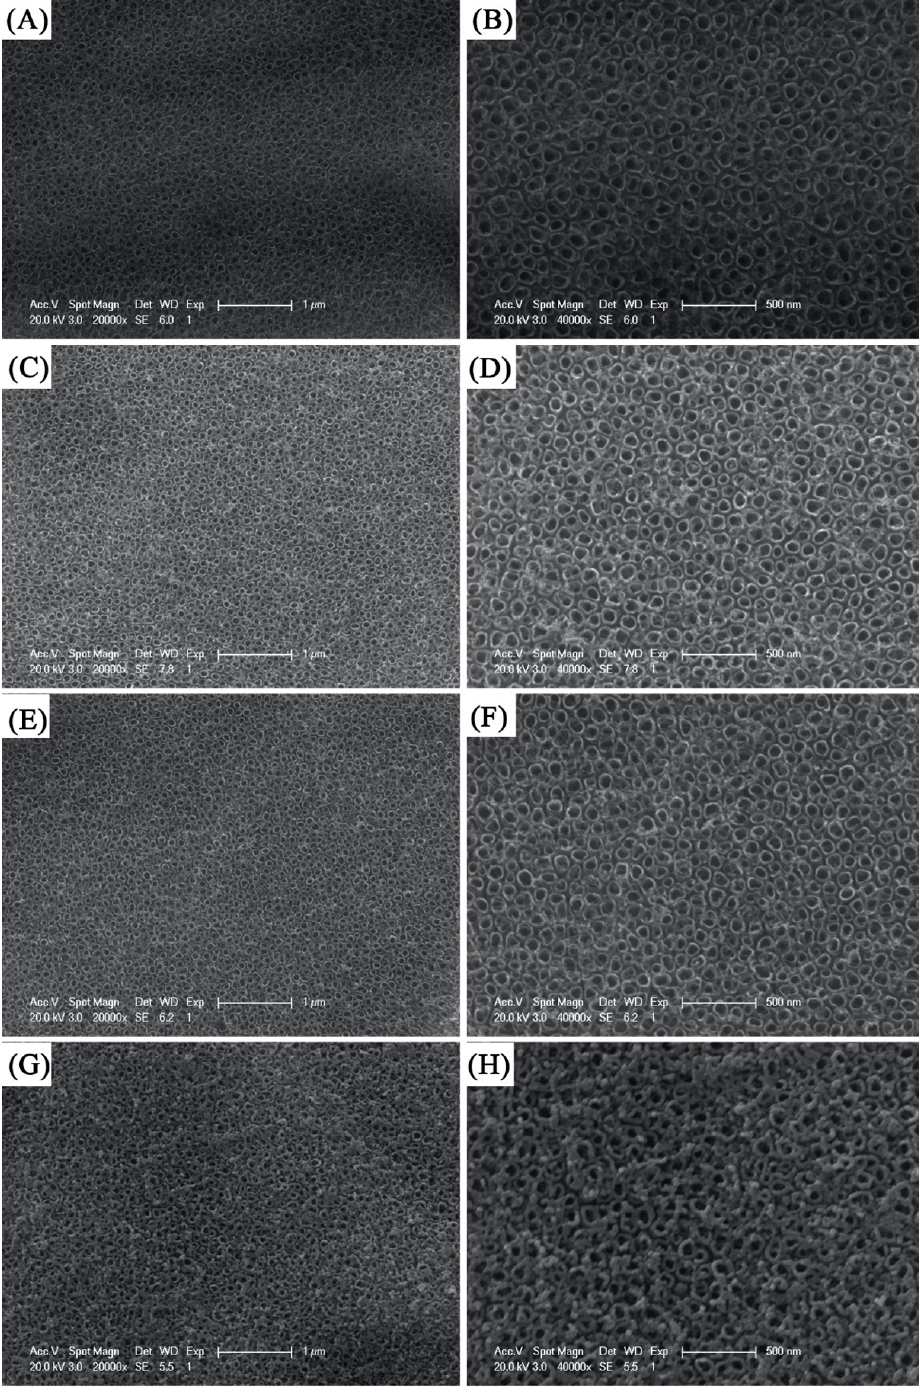
Figure 2. SEM images of Mo-TiO 2 nanotube array films ( A ) and ( B ): samples with Mo-doped concentration of 1.0%; ( C ) and ( D ): samples with Mo-doped concentration of 0.5%; ( E ) and ( F ): samples with Mo-doped concentration of 0.25%; ( G ) and ( H ): samples with Mo-doped concentration of 0%.